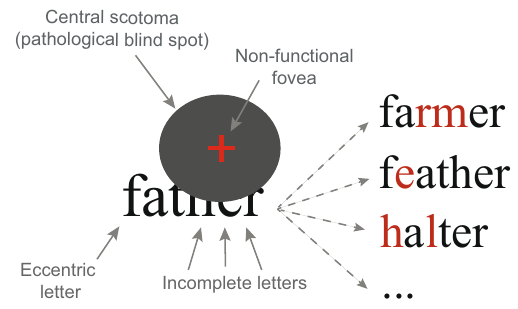
Figure 1. The presence of a central scotoma occludes part of the word “father”, leading to possible misidentifications, potentially due to: (1) incomplete letters (e.g., farmer); (2) eccentric letters, for which low acuity and increased crowding decrease identification performance (e.g., feather) or (3) both (e.g., halter). The overall lack of identification accuracy yields a greater need for linguistic